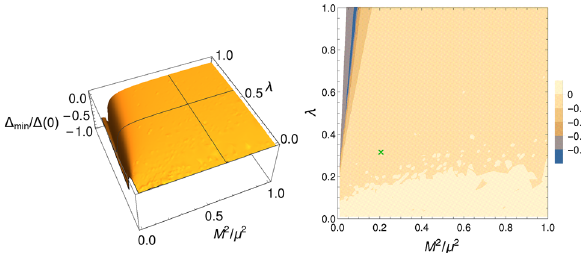
Fig. 13 Themagnitudeoftheviolationofreflectionpositivityobtained from the ratio min 0 < t < ∞ (cid:6)( t )/(cid:6)( t = 0 ) of the Schwinger functions in the smaller range of parameters, (left) 3D plot, (right) contour plot